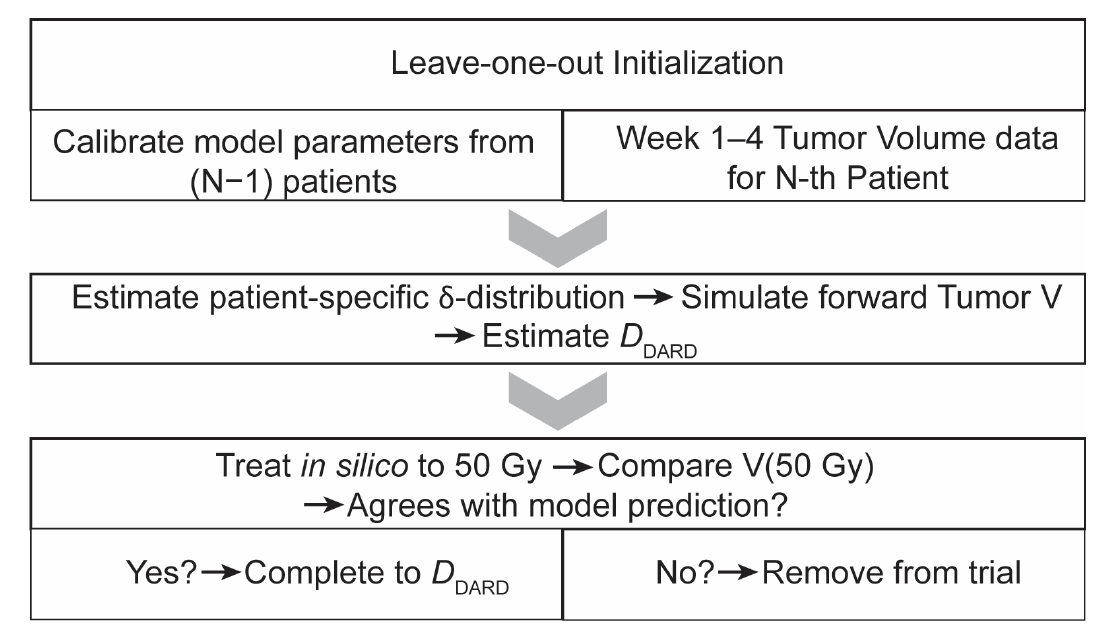
Figure 3. Flowchart description of in silico trial sequence. The trial has three major phases: (1) Leave-one-out initialization, where model parameters are calibrated from the training cohort and combined with tumor volume data from before the start of RT to week 4 of RT, (2) Personalized dose estimation, and (3) Safety check for model agreement with measured tumor volume after in silico treatment up to 50 Gy.